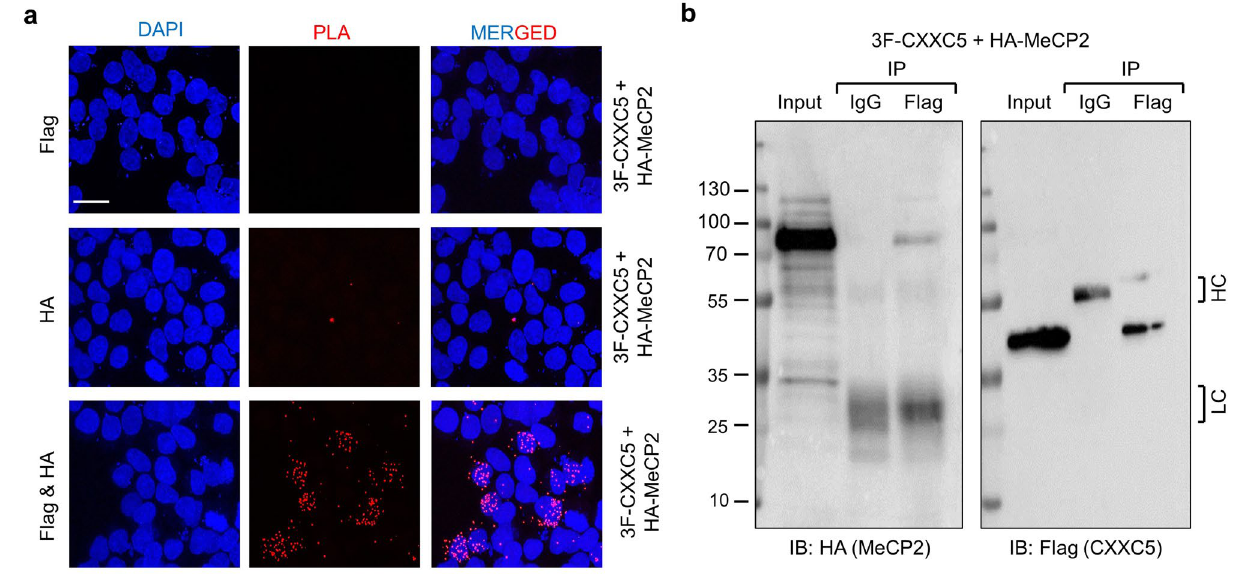
Figure 5. In cellula interaction of CXXC5 and MeCP2. ( a ) Proximity ligation assay (PLA). To assess the in cellula interaction of CXXC5 and MeCP2, HEK293 cells grown in coverslips were transiently co-transfected the expression vector bearing the 3F-CXXC5 or HA-MeCP2 cDNA. Cells were fixed, permeabilized, blocked, and probed with the HA and/or the Flag antibody. Cells were then subjected to fluorescent probes for circular DNA amplification. DAPI was used for nuclear staining. The scale bar is 25 µm. ( b ) Chromatin immunoprecipitation assay (ChIP)-WB. Co-transfected cells were also subjected to ChIP using the Flag antibody or the isotype- matched IgG followed by immunoblotting using the HA antibody. The membrane was also re-probed with the Flag antibody. HC and LC indicate the heavy and light chain of IgG. 10% of ChIP was used as input together with the deleted CXXC domain did not show an interaction in either immunoprecipitants or in cells as assessed with PLA (Supplementary Information Fig. S6). On the other hand, the remaining of the CXXC5 vari- ants, including the CXXC domain alone, 3F-CXXC, were detectable with the Flag antibody in the HA, but not in the IgG, precipitated lysate. The sequential residues at the domain (threonine, glycine, histidine, and glutamine amino acids, TGHQ) are critical for the binding of the CXXC domain to DNA 23,32,55 . To assess whether DNA binding defective CXXC5 interacts with MeCP2, we generated full-length 3F-CXXC5 DBM and 3F-CXXC DBM mutants by converting the TGHQ sequence to AAAA. 3F-CXXC DBM as the full-length 3F-CXXC5 DBM retained the interaction with MeCP2. These results collectively suggest that the carboxyl-terminal CXXC domain of CXXC5 is the required region to interact with MeCP2 independently of its ability of binding to DNA. It should be noted that although the CXXC domain is the required region of CXXC5 for protein interac- tions, the central region of CXXC5, aa 101–150, could contribute to the stability/affinity of protein interactions. We observed that the 3F-CXXC5Δ 100-149 variant, similar to the CXXC domain alone (3F-CXXC), consistently showed a lesser degree of interaction with MeCP2 compared to, for example, 3F-CXXC5, 3F-CXXC5Δ 150-199 , 3F-CXXC5Δ 200-249 , or 3F-CXXC5Δ 1-100 . To examine whether we could also locate a region of MeCP2 involved in the interaction with CXXC5, we generated MeCP2 variants. An initial screening of MeCP2 variants suggested that the carboxyl-terminus of MeCP2 is involved in the interaction with CXXC5. A previous detailed study indicated that the carboxyl-terminus of MeCP2 is required for the interaction with FBP11, the protein product of PRPF40A (Pre-mRNA Processing Factor 40 Homolog A) and HYPC, the protein product of PRPF40B (Pre-mRNA Processing Factor 40 Homolog B) 56 ; as the truncation of the carboxyl-terminal 86 amino acids containing the WW protein interaction domain of MeCP2, which also results from a frameshift mutation present in a group of Rett syndrome patients, abrogates interactions with FBP11 and HYPC. In transiently transfected HEK293 cells, the nuclearly localized (data not shown) the HA, or the Flag (data not shown), tagged MeCP2 variant lacking 86 amino acids from the carboxyl terminus (MeCP2 1-400 ) (Fig. 7a) displays a MM of about 55 KDa (Δ) compared to the full-length (FL) HA-MeCP2 which exhibits an apparent MM of 80 kDa (Fig. 7b). Immunoprecipitation of HA-MeCP2 1-400 , or Flag-MeCP2 1-400 , with the HA antibody from nuclear extracts of HEK293 cells co-synthesizing 3F-CXXC5, or HA-CXXC5, revealed that the interaction of CXXC5 with MeCP2 1-400 decreases dramatically compared to HA-MeCP2 or Flag-MeCP2 (Fig. 7c,d; Supplementary Information Fig. S7c,d). These results suggest that the carboxyl-terminus of MeCP2 is a critical region for interaction with CXXC5 as well. Moreover, the CXXC domain of CXXC5, 3F-CXXC, appears to be sufficient for the interaction of CXXC5 with HA-MeCP2 but not HA-MeCP2 1-400, as the HA antibody specifically immunoprecipitated 3F-CXXC from nuclear extracts of HEK293 cells co-synthesizing HA-MeCP2 (Fig. 7e,f; Supplementary Information Fig. S7e,f). Similarly, the immunoprecipitation of 3F-CXXC with HA antibody from cellular extracts of HEK293 cells co-synthesizing HA-EMD or HA-MAZ (Supplementary Information Fig. S8a,b) further suggests that the CXXC domain of CXXC5 is also a critical region for the interaction with EMD or MAZ.